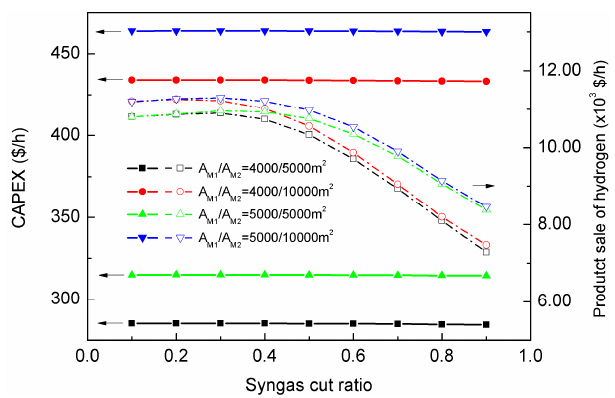
Figure 14. Evaluations on capital expense (CAPEX) and hydrogen product sale.